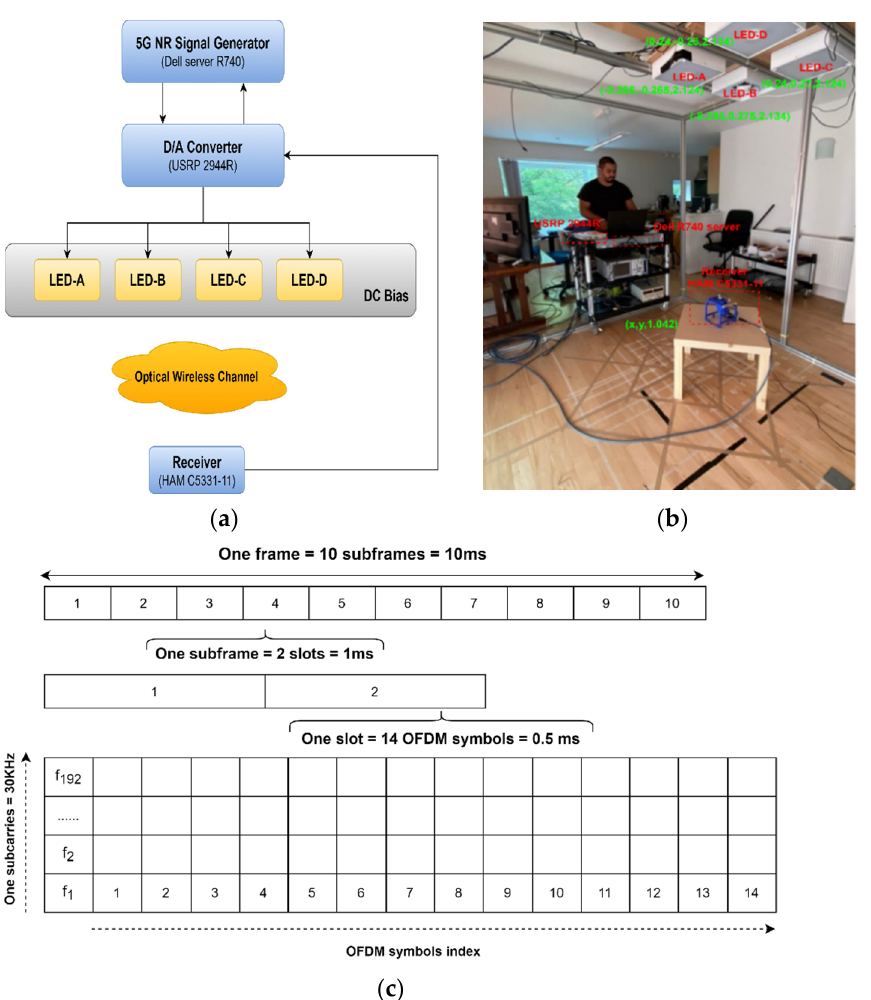
Figure 4. ( a ) A flow chart of the demonstration; ( b ) The realistic scenario; ( c ) The structure of 5G NR signal.